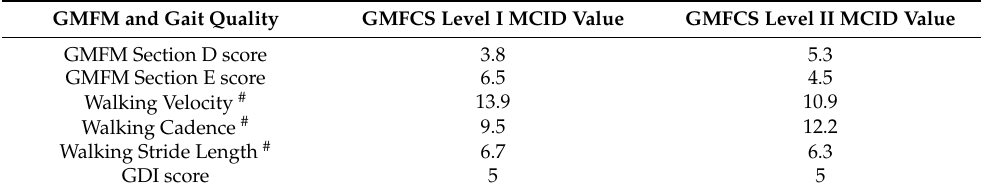
Table 1. Minimum clinically important difference (MCID) for GMFCS Levels I and II from the literature